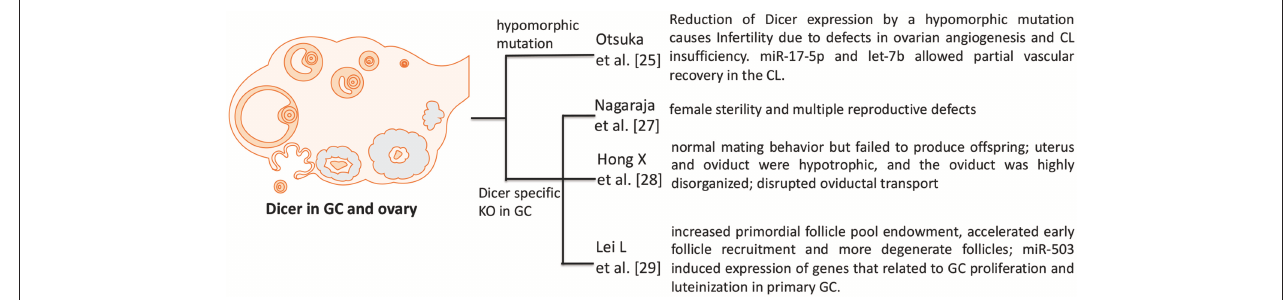
FIGURE 1 | Phenotypes in Dicer KO ovary. Four studies investigate the role of Dicer in GC and ovary. Otsuka et al. (25) use a Dicer hypomorphic mutation mouse. Other three papers [Nagaraja et al. (27), Hong et al. (28), and Lei et al. (29)] show that specific deletion of Dicer in GC hampers the normal function and development of folliculogenesis in ovary.